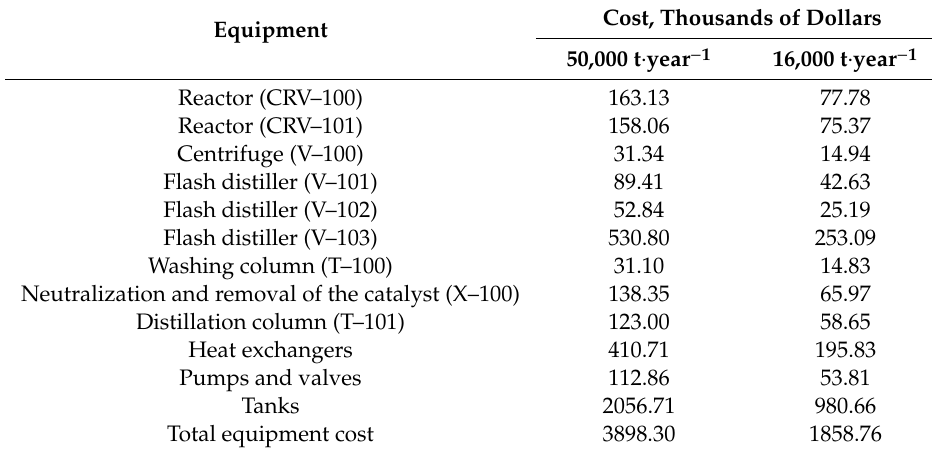
Table 7. Estimation of equipment